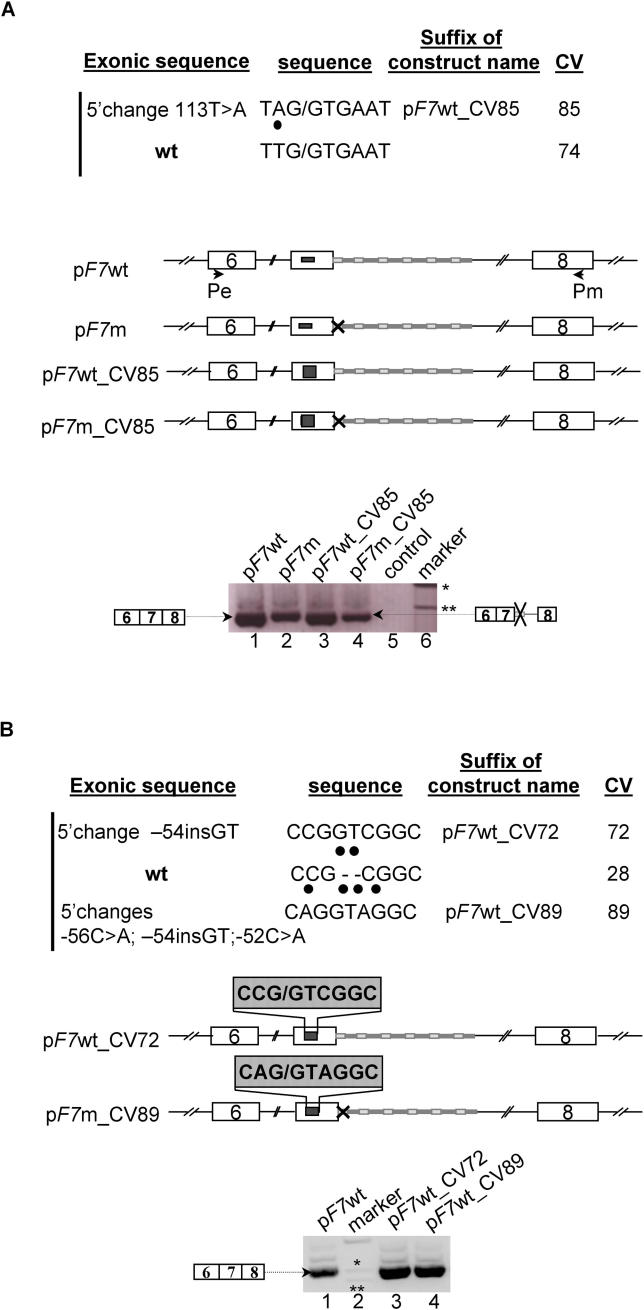
Effect on the Splice Site Selection of Exon 7 Sequences with Increased Complementarity to U1snRNA(A) Splicing of F7 transcripts generated from F7 minigenes harbouring an exonic cryptic site at −113 with a CV of 85.(B) Splicing of F7 transcripts generated from F7 minigenes harbouring an exonic cryptic site at −54 with a CV of 72 or 89.(A and B) Top: Wild-type (lower line in [A], middle line in [B]) and mutated (upper lines in [A], lower and upper line in [B]) 5′ pseudo-sites in the F7 minigene. Dots show the location of the introduced mutations. Suffixes of the constructs' names and the resulting CVs are indicated. Middle: Schematic representation of the constructs transfected in CHO cells. Improved splice sites are represented by a hatched square (see legend to Figure 2A for the meaning of each symbol). Bottom: RT-PCR amplification of F7 transcripts isolated from CHO cells transfected with the above-mentioned constructs. The products corresponding to the different PCR fragments, as identified by sequencing, are schematically represented on both sides of the figure.